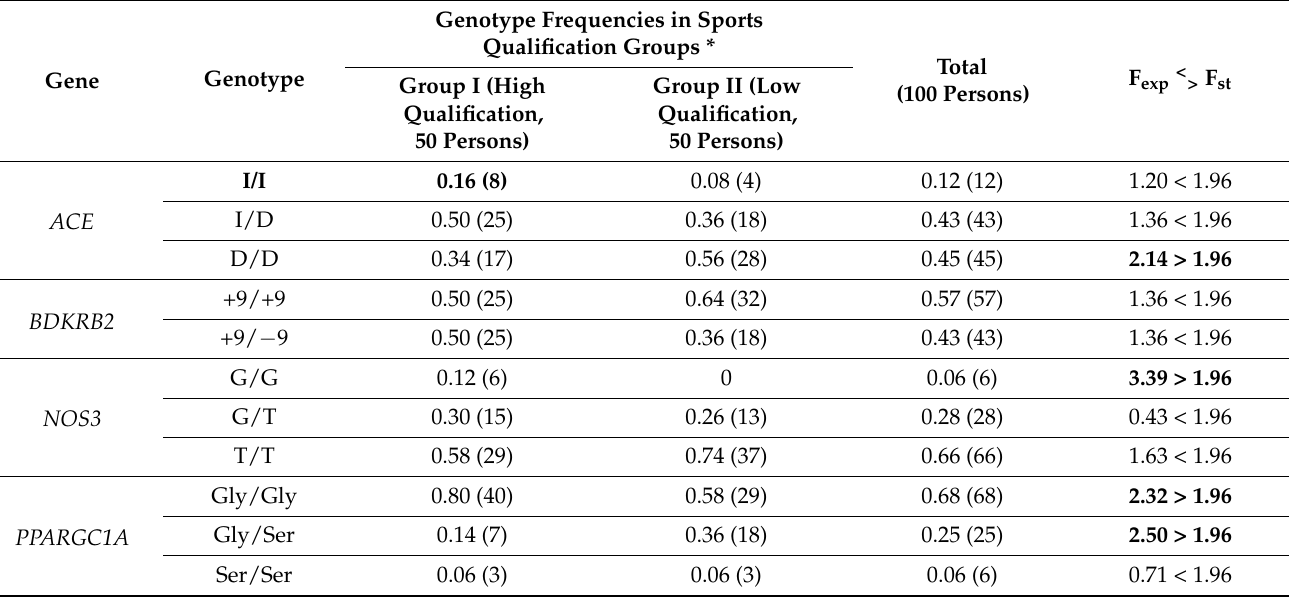
Table 2. Frequencies of the genotypes of the ACE , BDKRB2 , NOS3 , PPARGC1A genes in martial arts practitioners with different qualifications ( n =